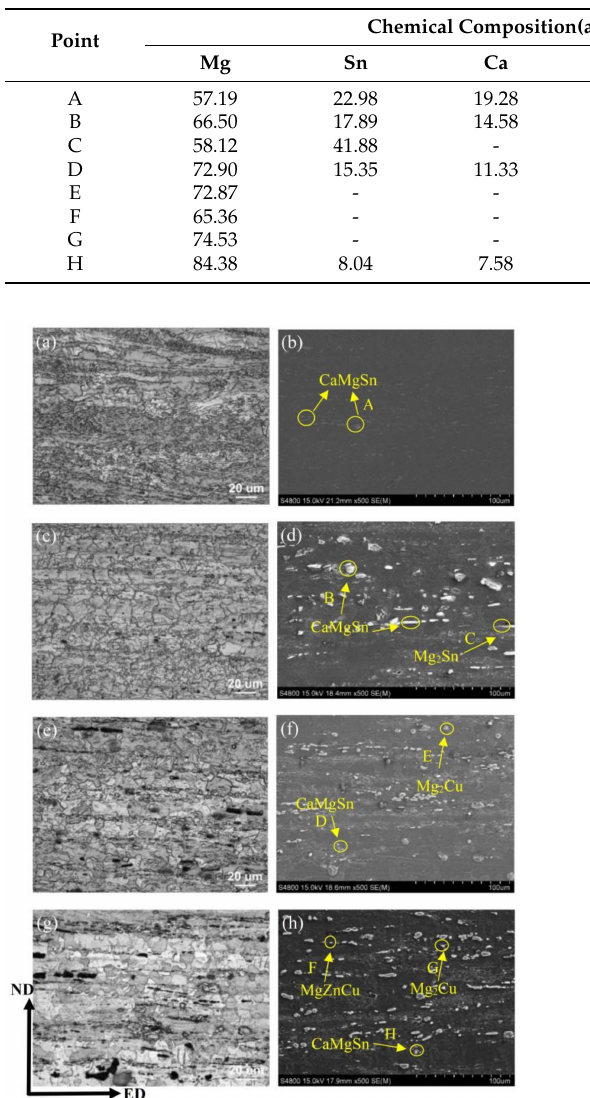
Table 3. EDS analysis results.